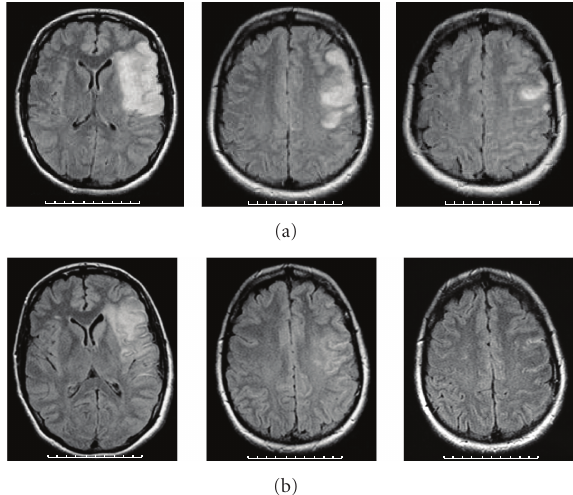
Figure 3: MRI T2 flair-weighted images showing left superficial MCA infarct. (a) 24 hours after stroke onset, (b) 5 days after stroke onset.